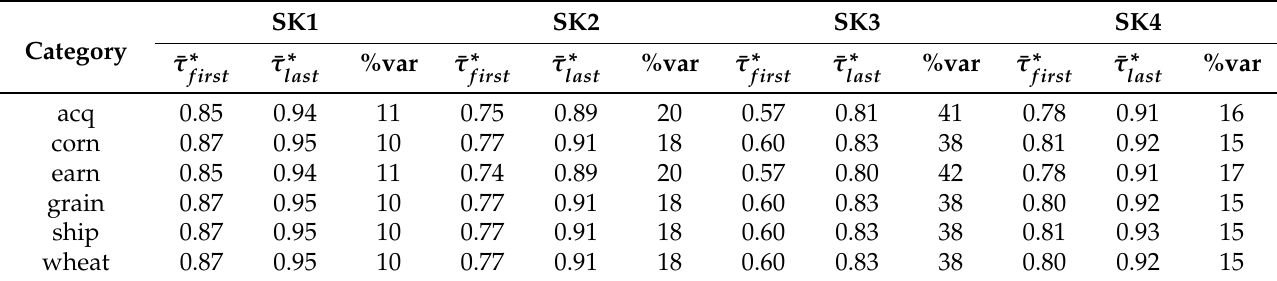
Table 2. Average of the computed collective concordance indices per category ( m = 3).